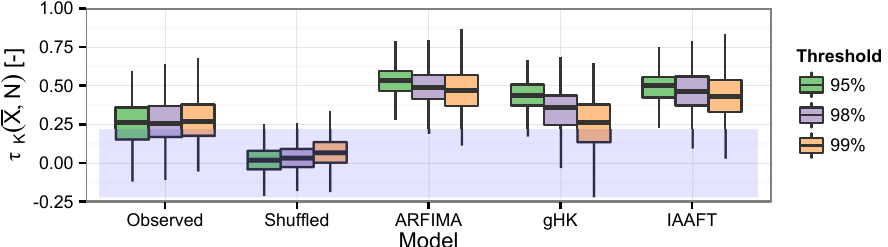
Figure 15. Box plots of the Kendall correlation coefficient τ K between ¯ X = S / N and N for observed and simulated data referring to flow values exceeding the three quantile thresholds. Shaded area denotes the 95% confidence interval around the zero value for the average sample size of the pairs ( ¯ X , N ) .